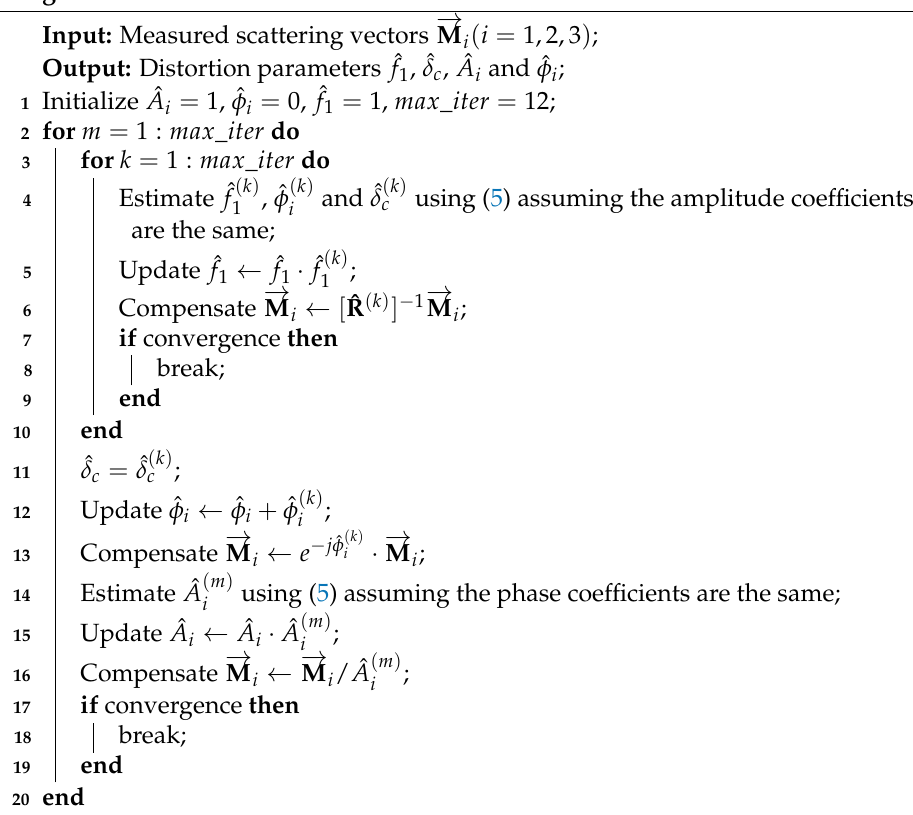
Algorithm 1: ICT calibration